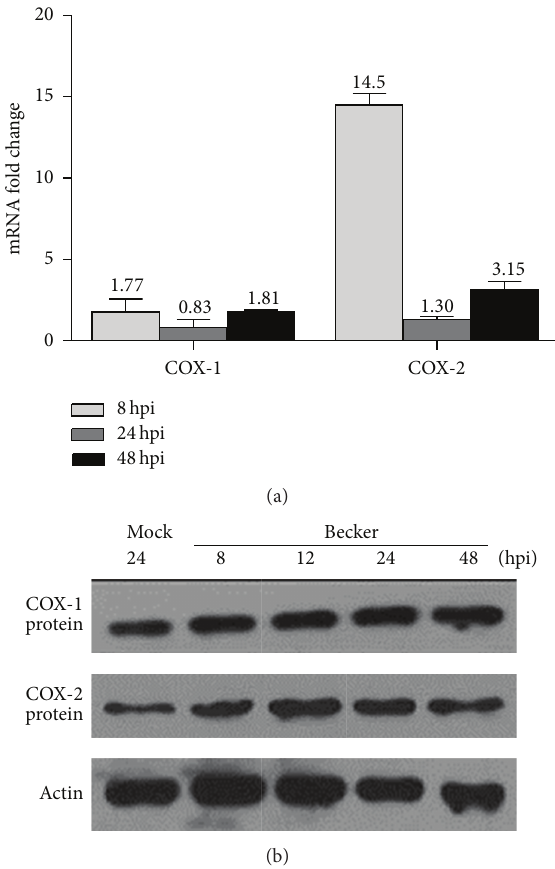
Figure 3: HSV-1 infection induces COX-2 mRNA and protein expression. (a) The numbers show the precise fold changes at indicated times after infection with COX-1 or COX-2-specific primers. (b) Western blotting shows the expression pattern of COX- 1/COX-2followingHSV-1infectionatindicatedtimepoints(toptwo